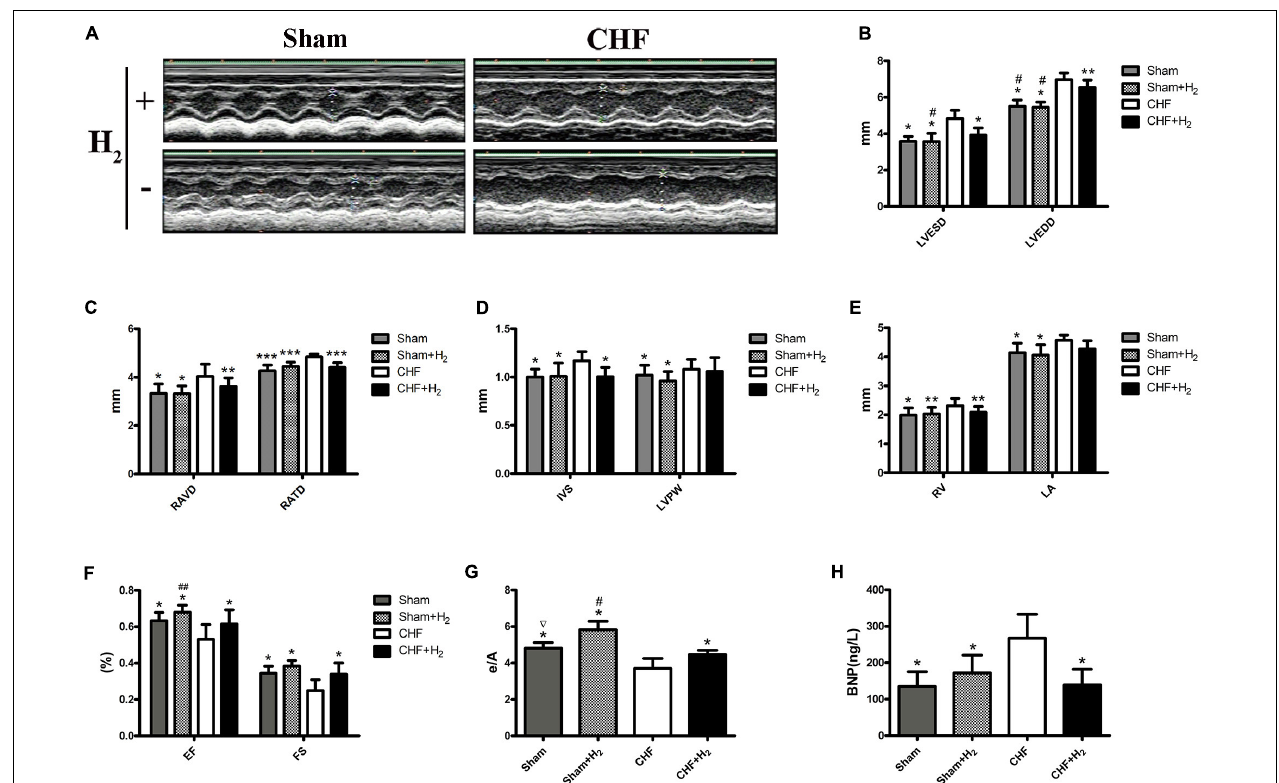
FIGURE 3 | Cardiac structure and function. (A) One month post-ISO injection, the rats were treated with H 2 for 14 days. Cardiac structure and function were measured with M-mode echocardiography. Representative M-mode echocardiographic photographs of LV are shown. (B–G) LVESD, LVEDD, RAVD, RATD, IVS, LVPW, RV, LA, EF, FS, and E/A values are shown ( n = 9–11). (H) BNP level in serum ( n = 10). The columns indicate the mean, and the bars indicate the SD. ∗ p < 0.01 vs. CHF; ∗∗ p < 0.05 vs. CHF; ∗∗∗ p < 0.0083 vs. CHF; # p < 0.01 vs. CHF+H